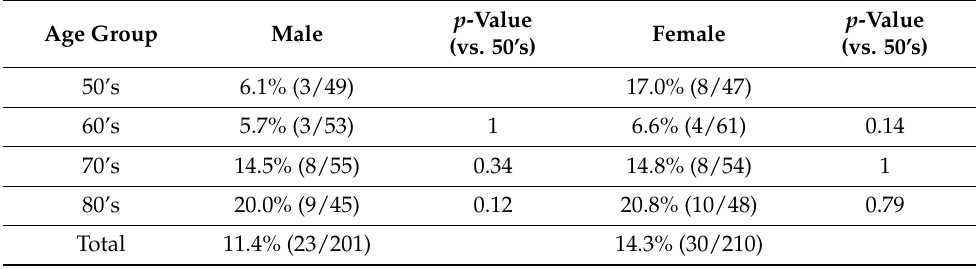
Table 2. Prevalence of low back